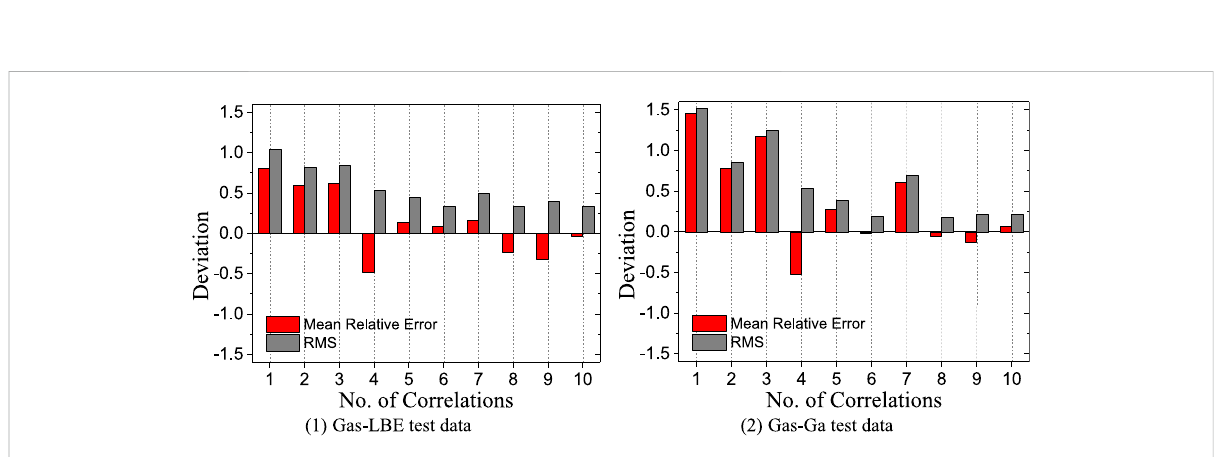
FIGURE 14 Statistical analysis of the predicted void fraction by correlations (1 — Ishii for bubbly, 2 — Ishii for slug, 3 — Ishii for churn, 4 — Kataoka and Ishii, 5 — Koca and Ishii, 6 — Mikityuk for pool, 7 — Mikityuk for loop, 8 — Shen for low wettability wall, 9 — Shen for high wettability wall, 10 — New developed model). (A) Gas-LBE test data. (B) Gas-Ga test data.